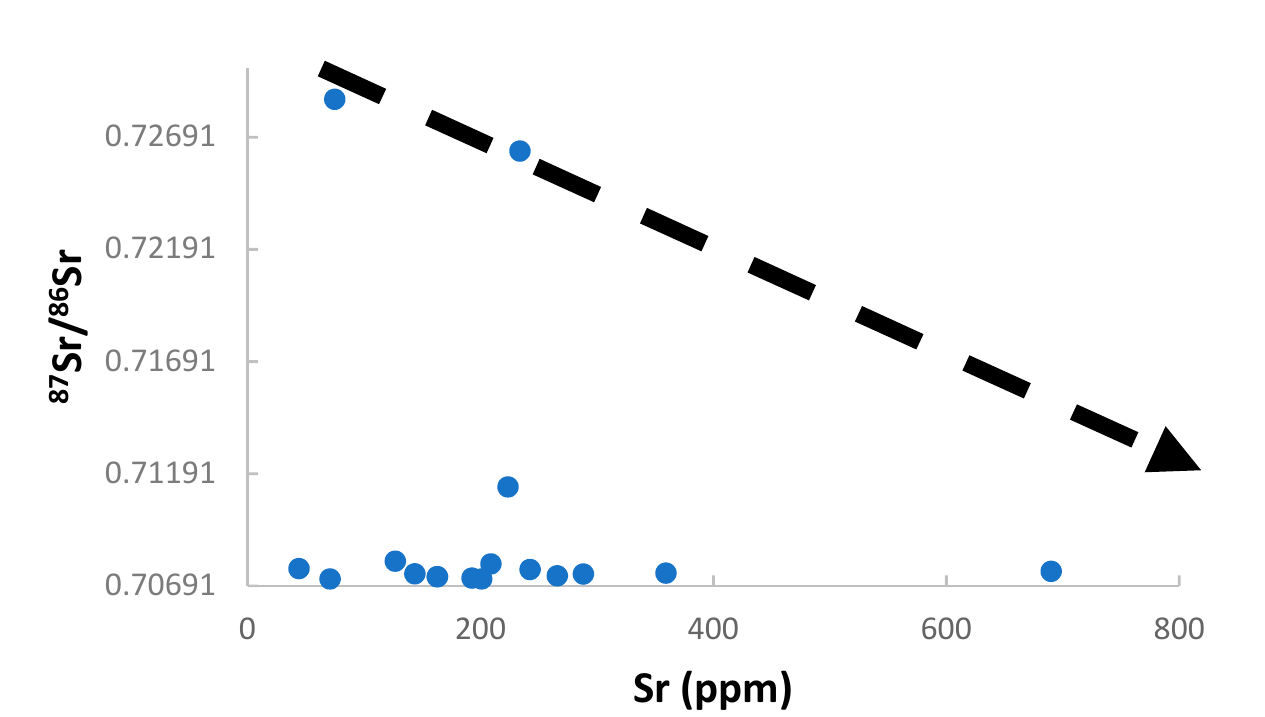
Figure 12. Strontium concentration v. 87 Sr/ 86 Sr ratios in host carbonate samples; note the variable data of Sr concentration and wide range of Sr isotope ratios.